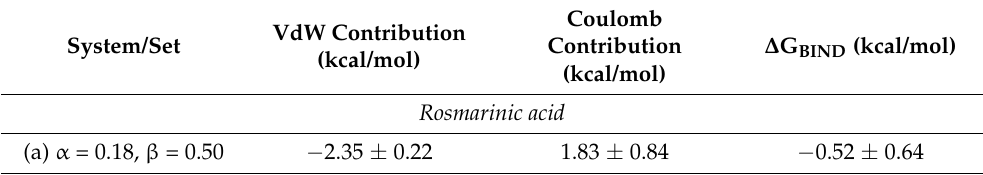
Table 3. The average electrostatic and van der Waals nonbonded contributions of rosmarinic acid to factor X binding, along with the binding free energy calculated using the LIE method. The standard LIE α and β parameters obtained from the work of Hansson et al. [48] were